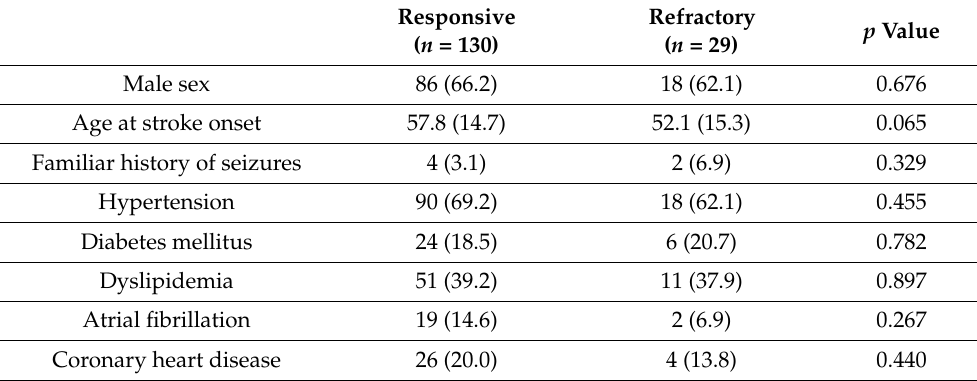
Table 1. Characteristics of patients according to treatment